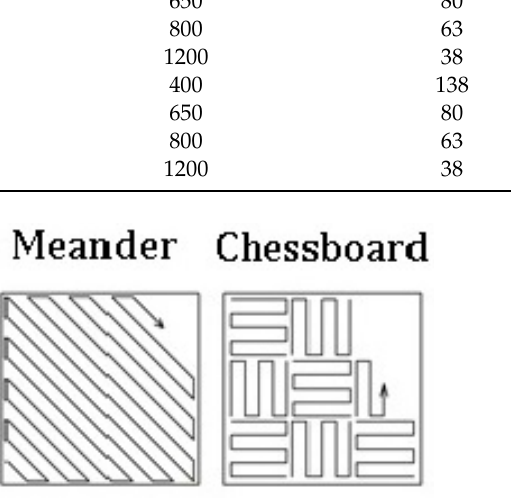
Figure 2. Used scanning strategies [21].